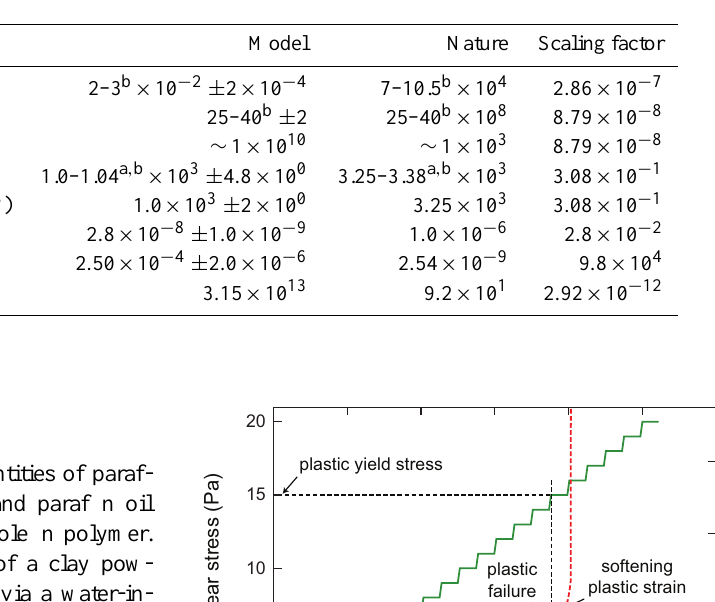
Table 1. Parameter values adopted for the models ( a refers to Exp. 2 and b refers to Exp. 3), scaled to nature and scaling factors. The plastic strength of the materials decreases with depth in each layer. In this table we indicate the strengths averaged over the layer thickness.